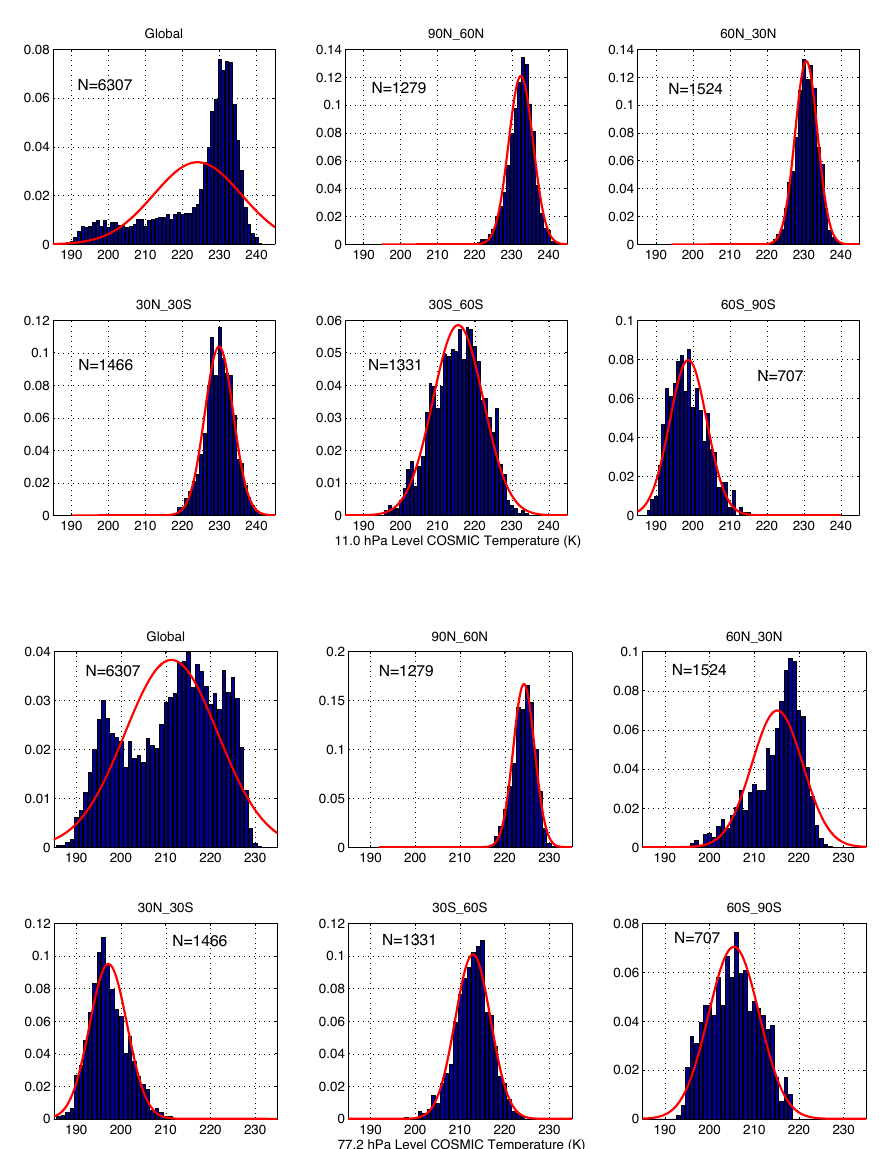
Figure 1. Probability density functions of COSMIC dry temperature in the stratosphere at 11hPa (upper six panels) and near the tropical tropopause at 77hPa (lower six panels) in one global and five latitude zones (blue), with overlaid normal distributions calculated from the mean and standard deviation (red). Data are extracted from the AIRS/COSMIC matchup data set for May 2012, with the number of matchup samples, N , for the corresponding latitude zone shown within each